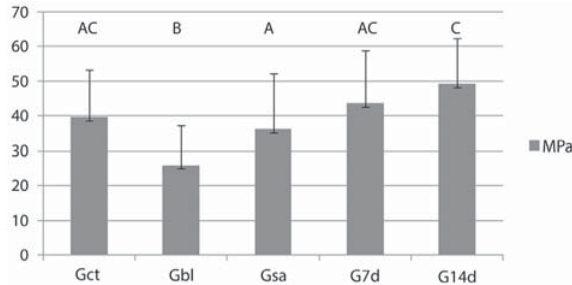
Table 1 illustrates premature failures and fracture mode 15 observed in the different experimental groups. Qualitative microscopic analysis